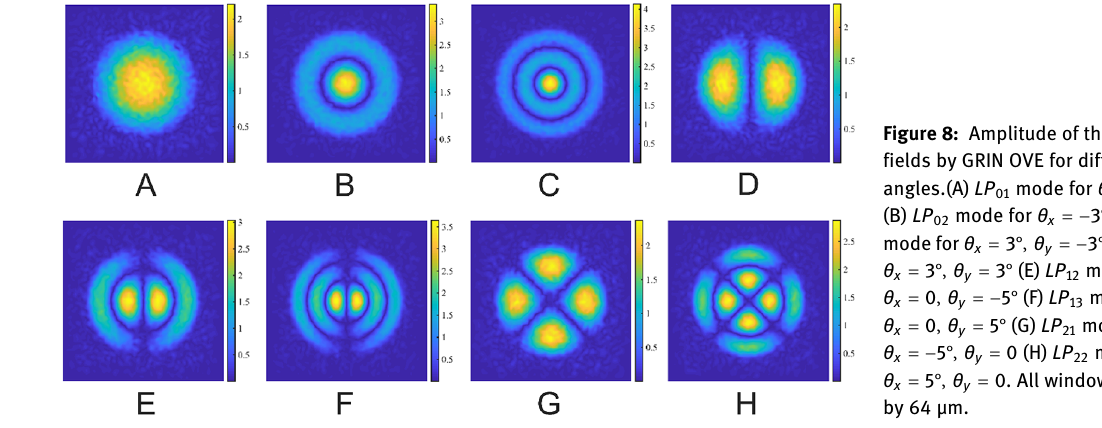
Figure 8: Amplitude of the reconstructed fields by GRIN OVE for different input angles.(A) LP 01 mode for θ x (cid:1) − 3 ° , θ y (cid:1) − 3 °